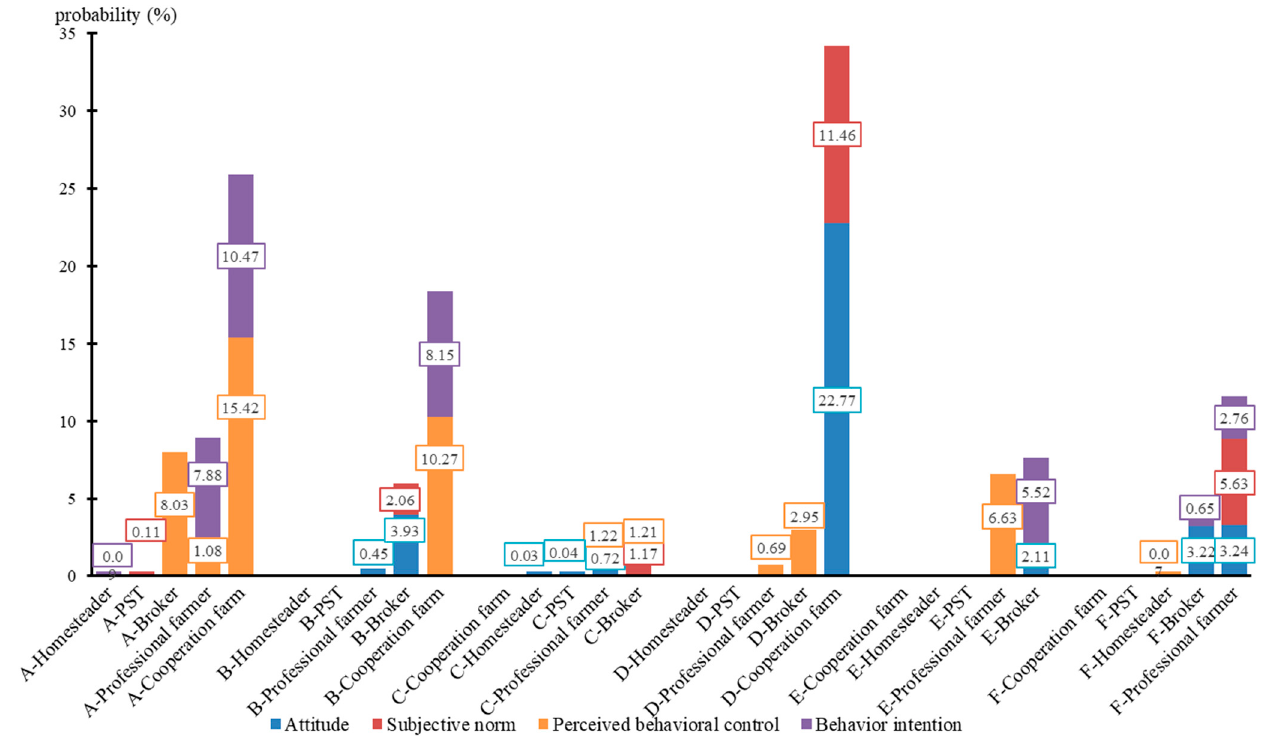
Figure 4. The impact of different psychological factors in the TPB for a particular contract type on different potential farmers. Note: “A” designates the contract type of “Purchase-1”, “B” of “Purchase-2”, “C” of “Ordinary purchase-1”, “D” of “Ordinary purchase-2”, “E” of “Ordinary purchase-3”, and “F” is the “Adjustment for bullish market”.